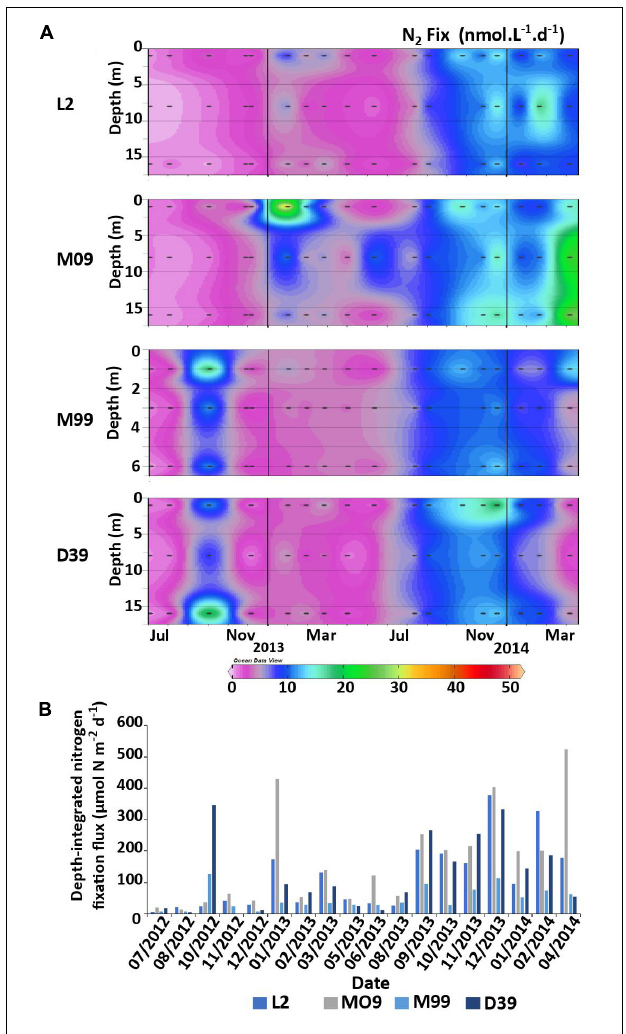
FIGURE 3 | Vertical distributions of N 2 fixation rates (nmol N L − 1 d − 1 ) over the 2-year survey at the stations L2, M09, M99, and D39 (A) . Temporal dynamics of integrated N 2 fixation rates at the four stations studied ( B ; the error bars correspond to the error propagation from the IRM